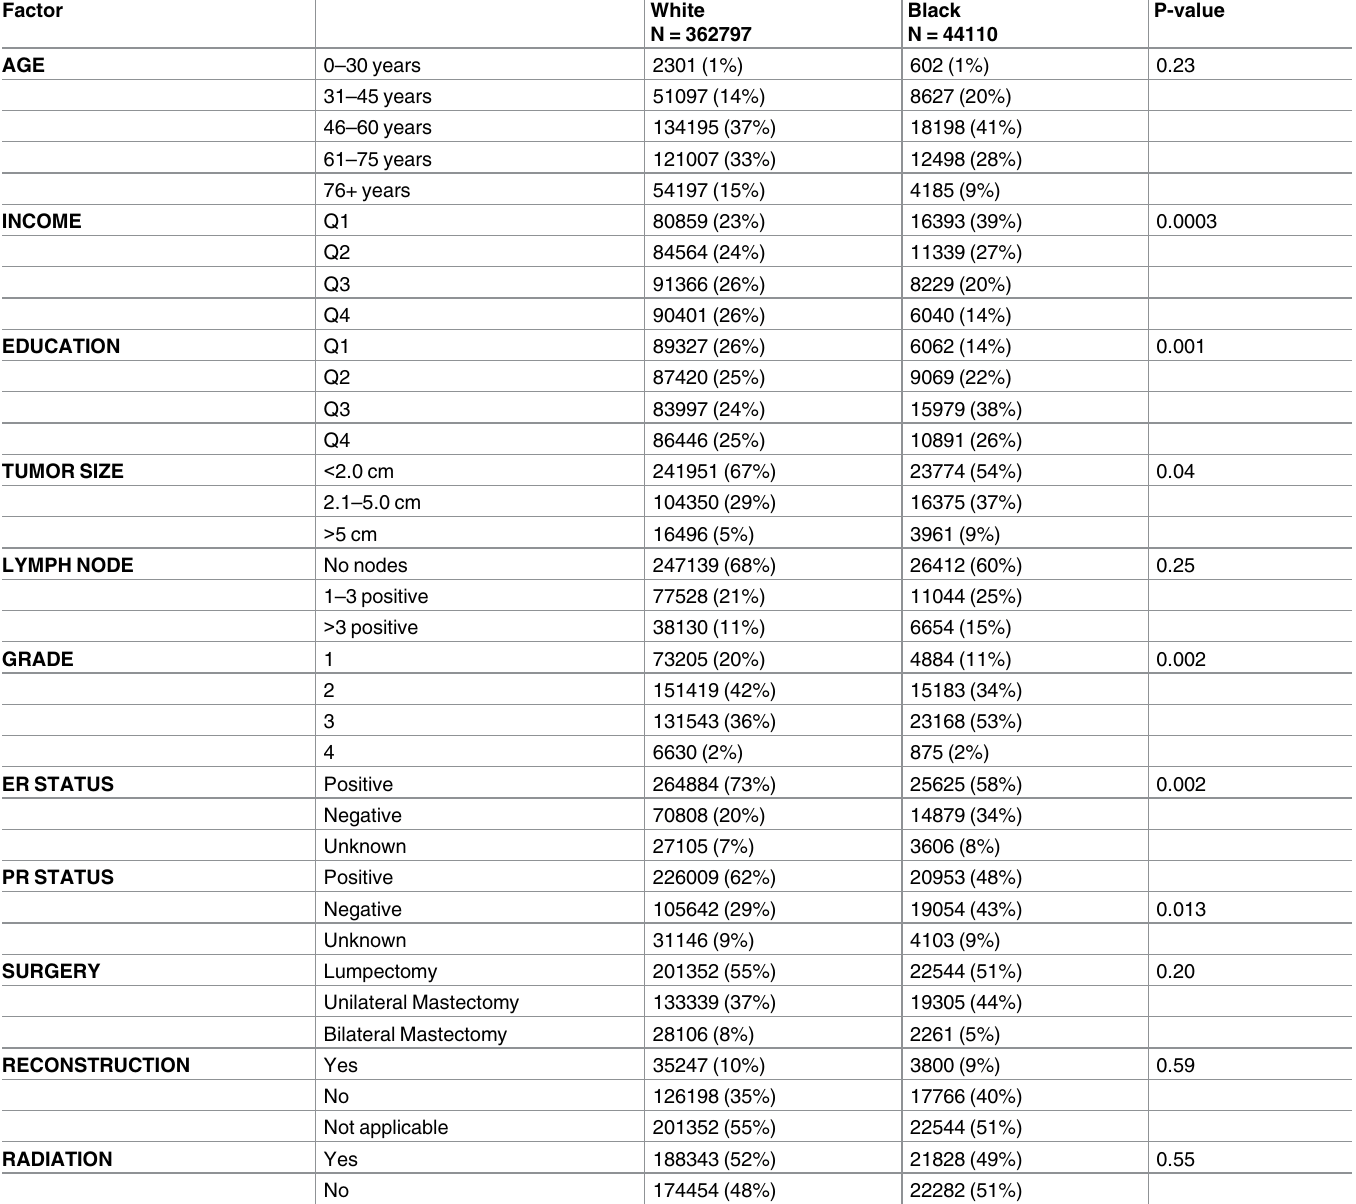
Table 1. Demographic and oncologic characteristics of Black and White